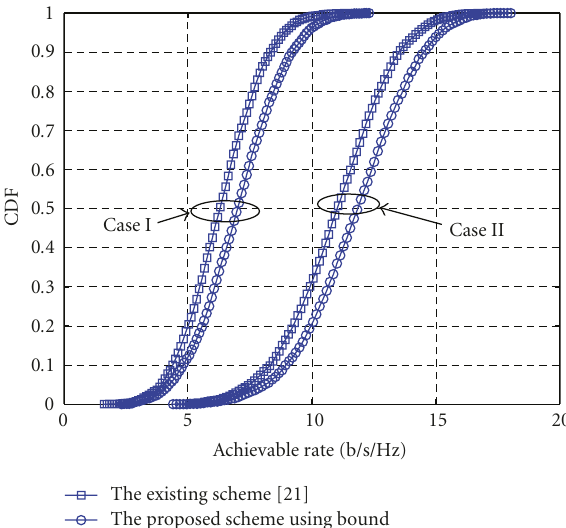
Figure 6: CDF comparison for two cases when K = 4. Case I: P s = P r = 15dB and Case II: P s = P r =